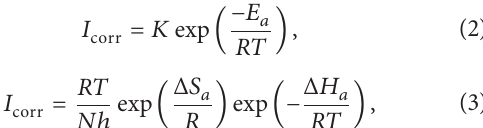
Figure 6: Arrhenius plots of corrosion ln (𝐼 HCl and at different concentrations of harmane.